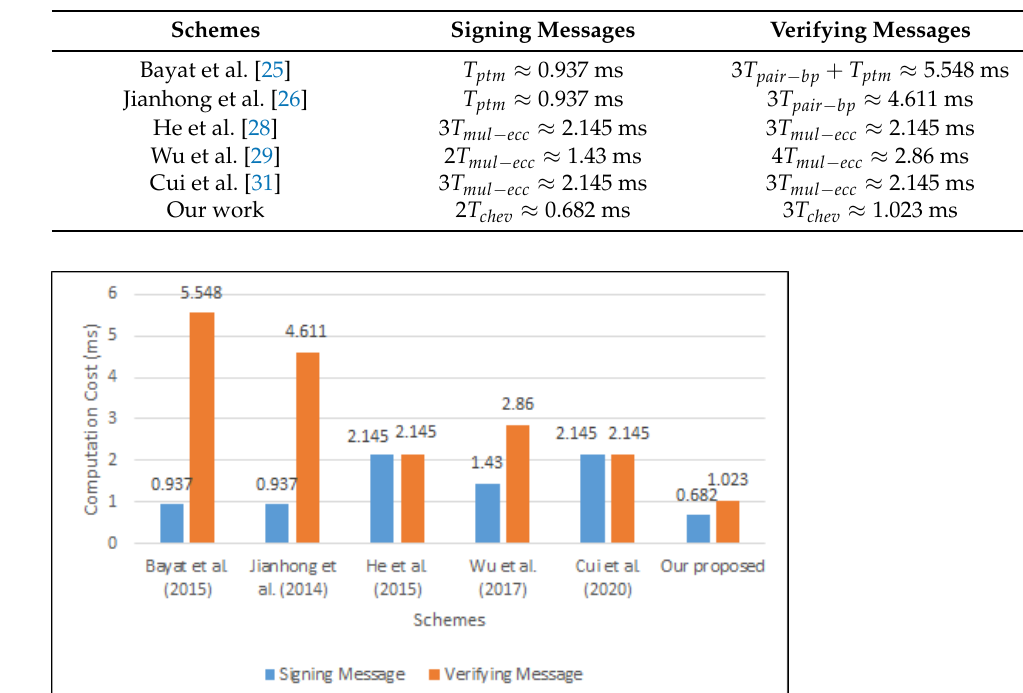
Table 4. Comparison of the signing and verifying messages.